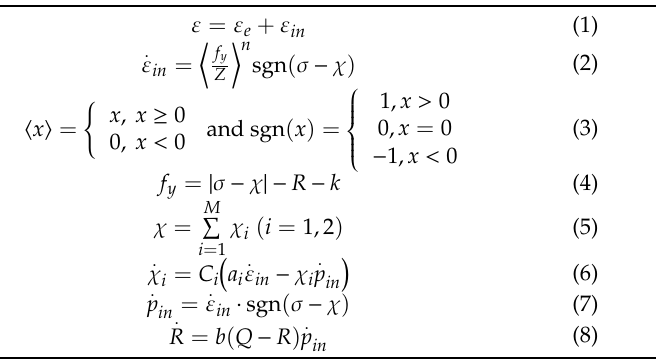
Table 3. Constitutive equations of the conventional Chaboche viscoplastic model.